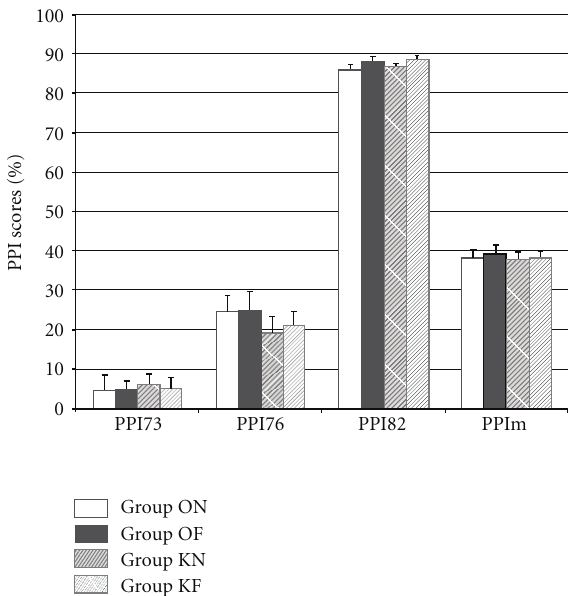
Figure 1: PPI scores (%) at PND35. PPI mean scores at PND35 are comparable between groups. No e ff ect of factors KA or FENO is found with the two-way ANOVA.